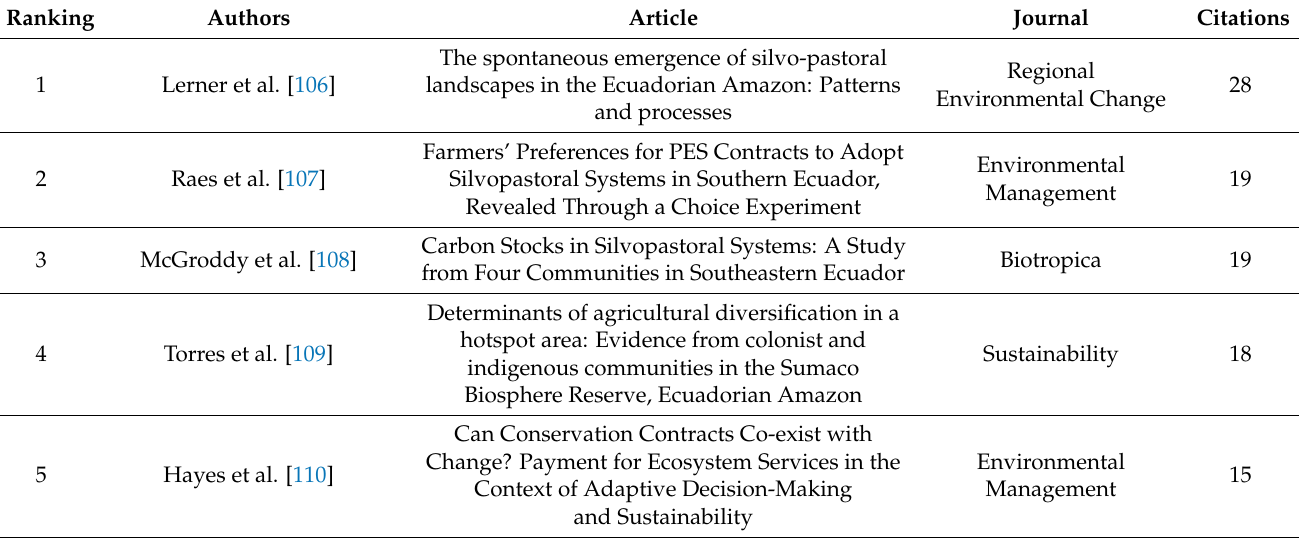
Table 4. Most cited documents on silvopastoral systems in